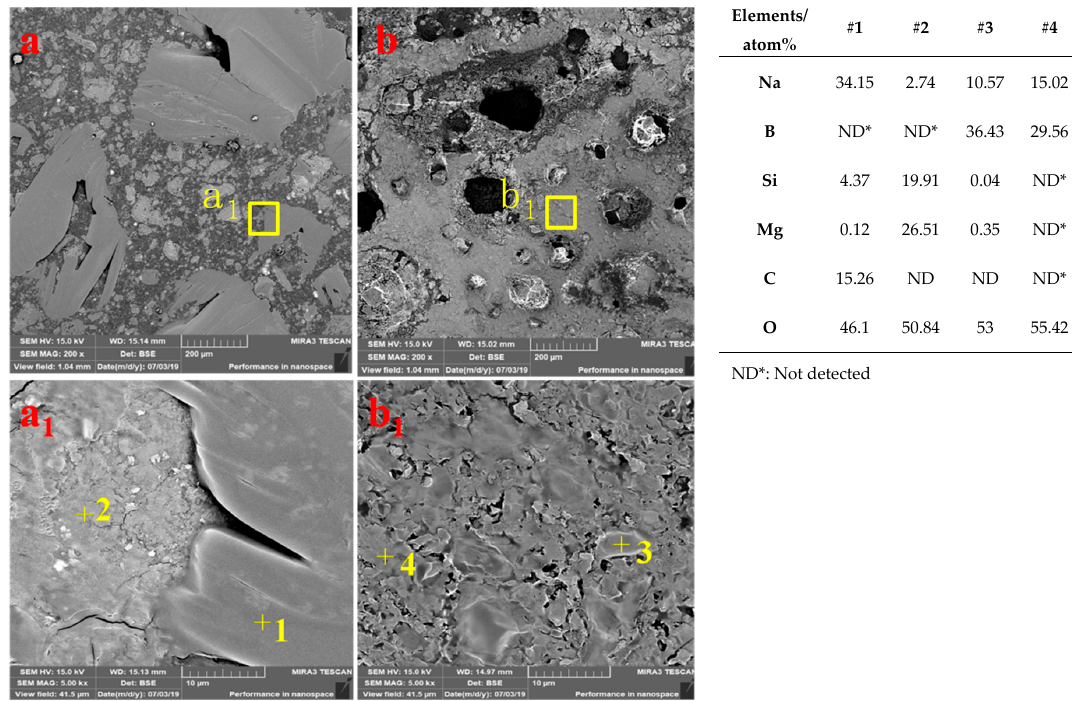
Figure 10. SEM-EDS results of ( a ) mixture of lizardite and sodium carbonate with molar ratio of 1:2 and, ( b ) mixture of szaibelyite and sodium carbonate with molar ratio of 1:1, roasted at 800 °C for 60 min in a nitrogen atmosphere. a1 and b1 are the partial enlarged details corresponding to a and b, respectively.